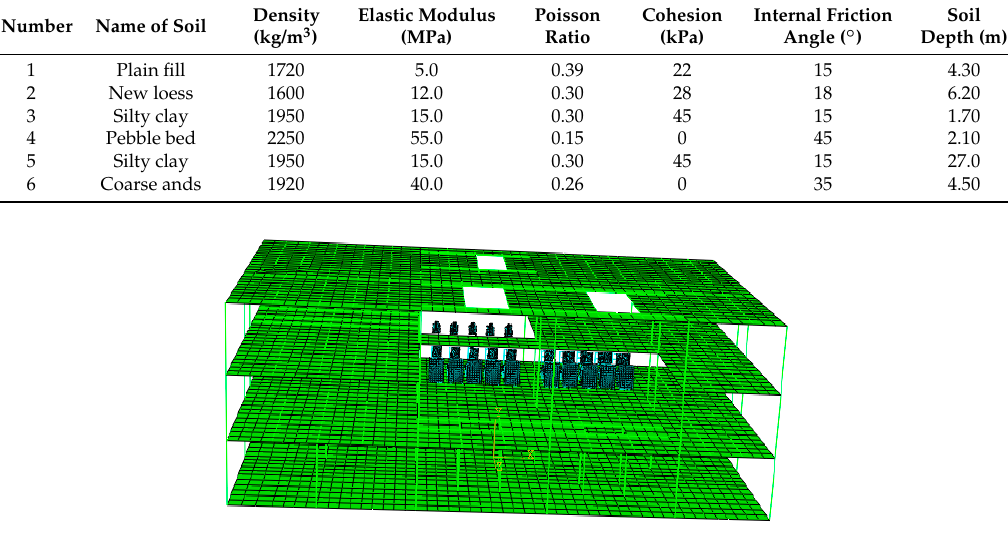
Figure 7. Finite element model of equipment.